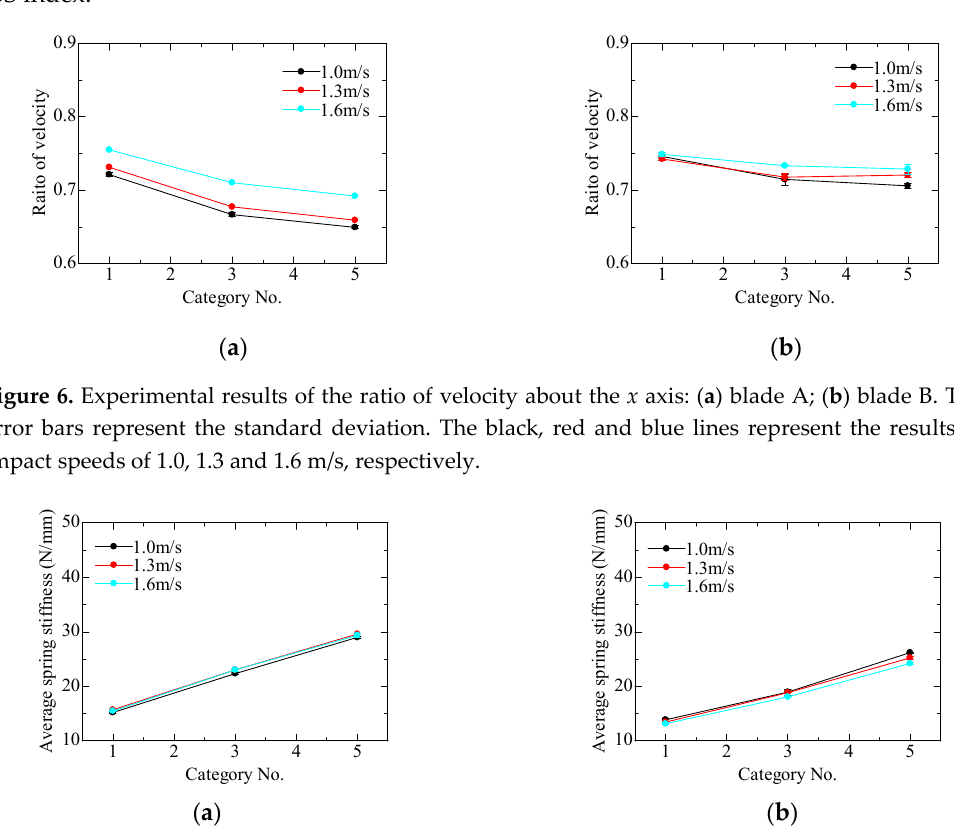
Figure 7. Experimental results of the average spring stiffness (ASS): ( a ) blade A; ( b ) blade B. The error bars represent the standard deviation. The black, red and blue lines represent the results at impact speeds of 1.0, 1.3 and 1.6 m/s,